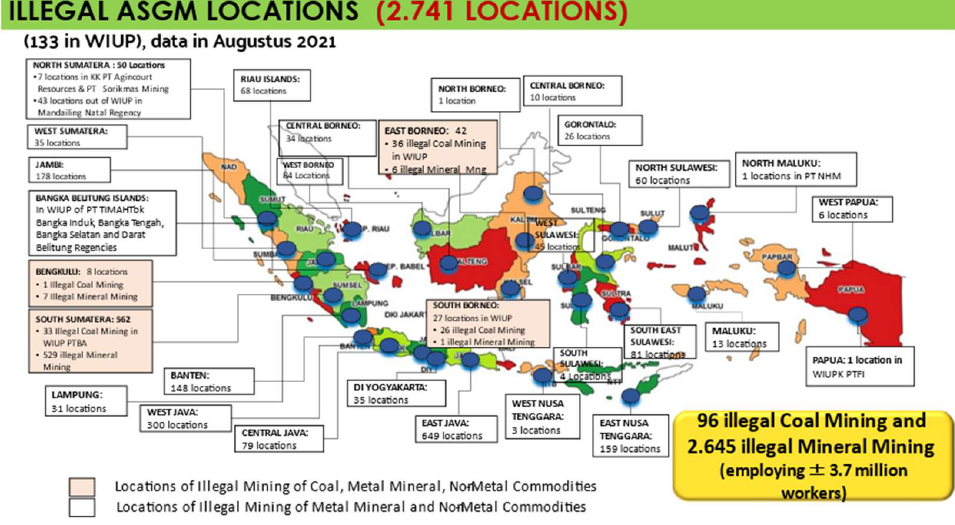
Figure 1. Locations of Illegal ASGM in Indonesia. Source: Directorate of Mineral and Coal of the Indonesian Ministry of Energy and Mineral Resources (2021).